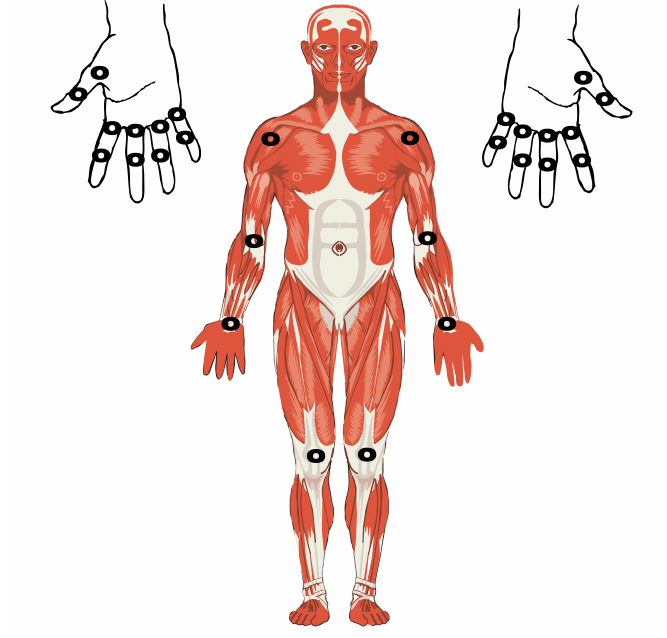
Figure 1. Measurement points in DAS 28